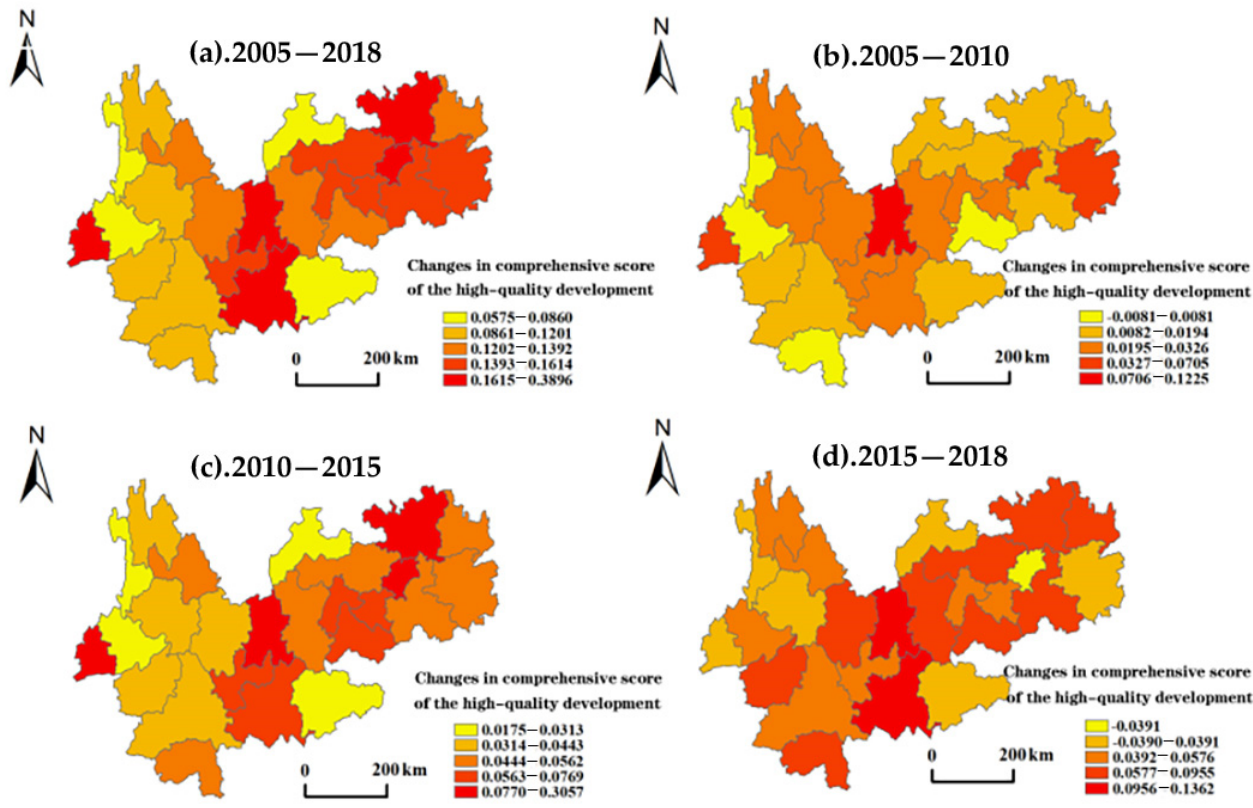
Figure 4. The Evolution of the high-quality development process in the YGR.